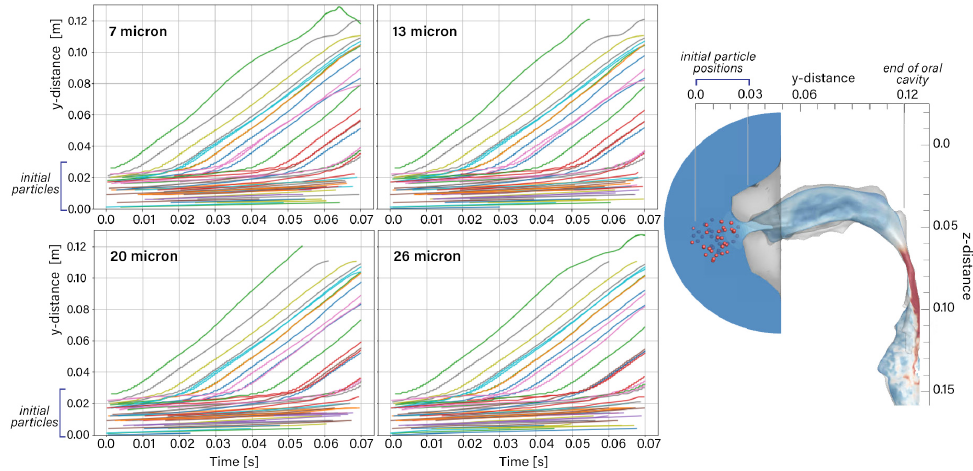
Figure 5. Particle penetration in the streamwise direction over the time period of t = 0.0 s to t = 0.07 s.